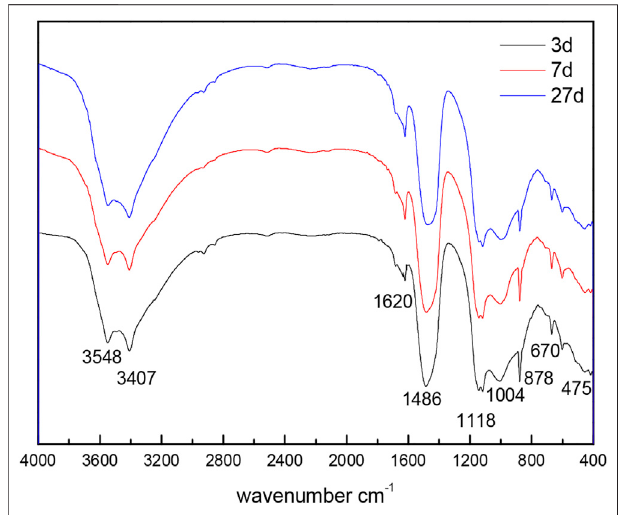
FIGURE 5 | FTIR test result of pastes at different